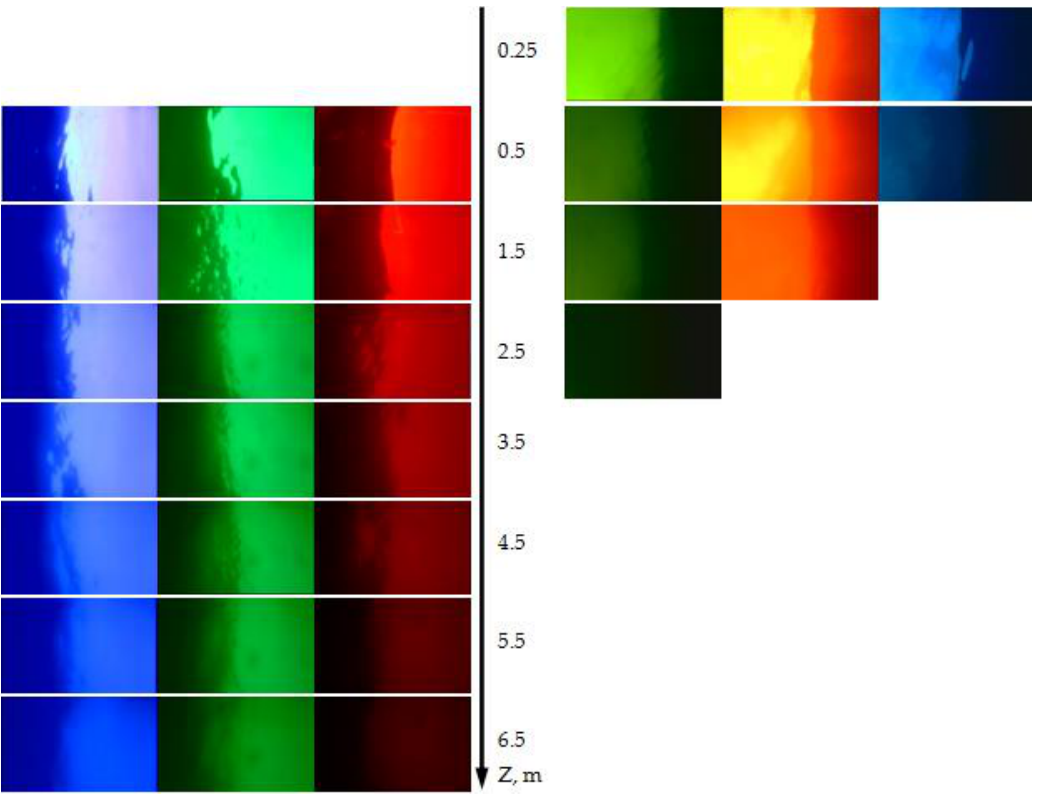
Figure 6. The transformation of the Snell’s window images with depth for three color filters (420 nm, 530 nm and 650 nm) in waters of the Black Sea (on the left) and the Gorky Reservoir (on the right).